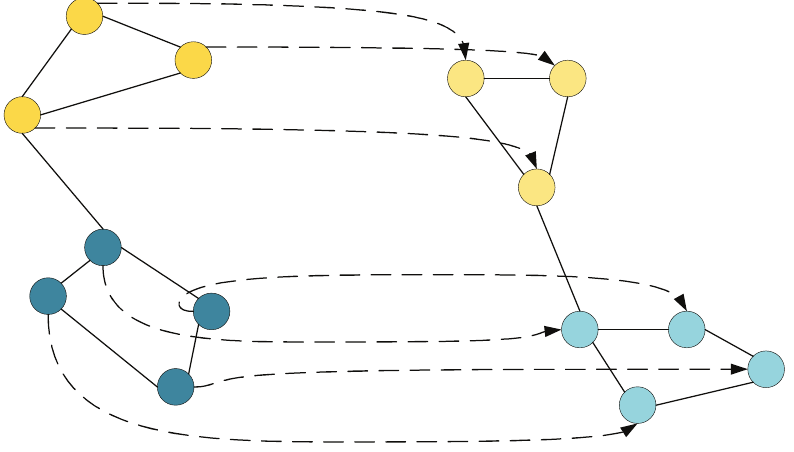
Figure 1. Graph matching schematic